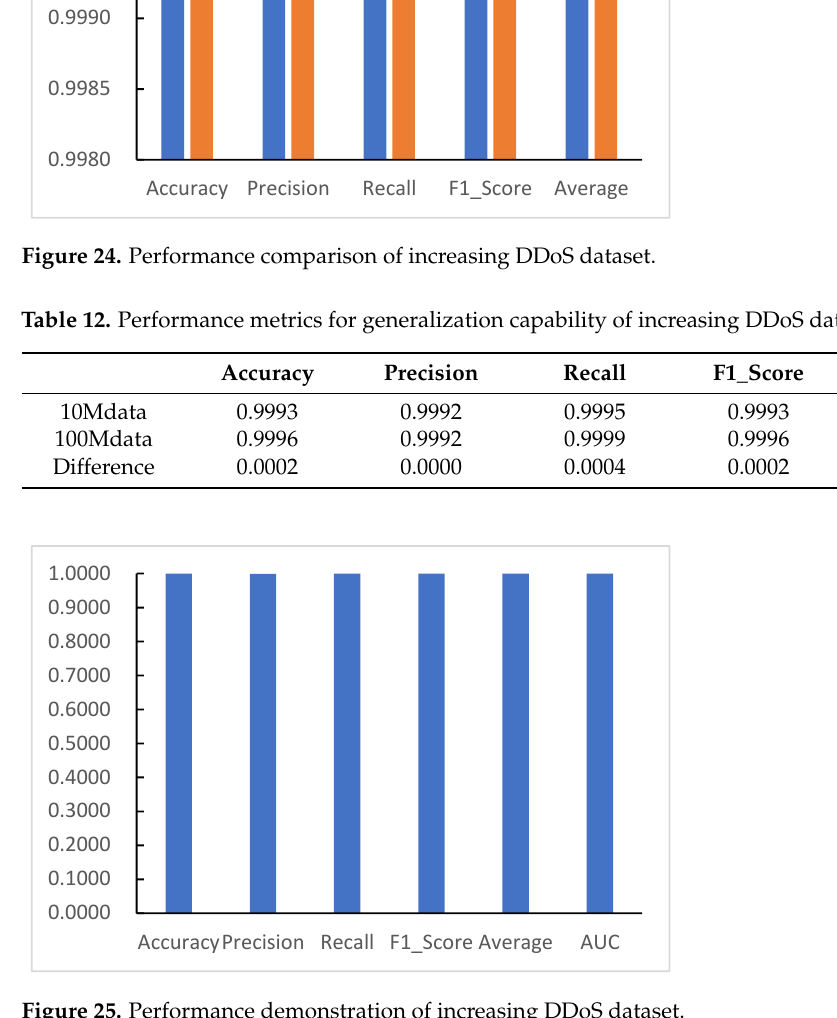
Figure 25. Performance demonstration of increasing DDoS dataset.